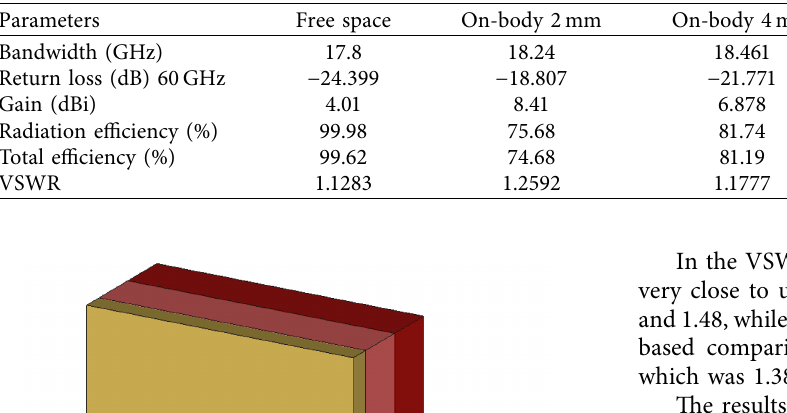
Figure 38: Radiation patterns of the single-element antenna for different distances (a) on XY plane and (b) on YZ plane. Table 4: On-body comparison of single-element array for different distances.